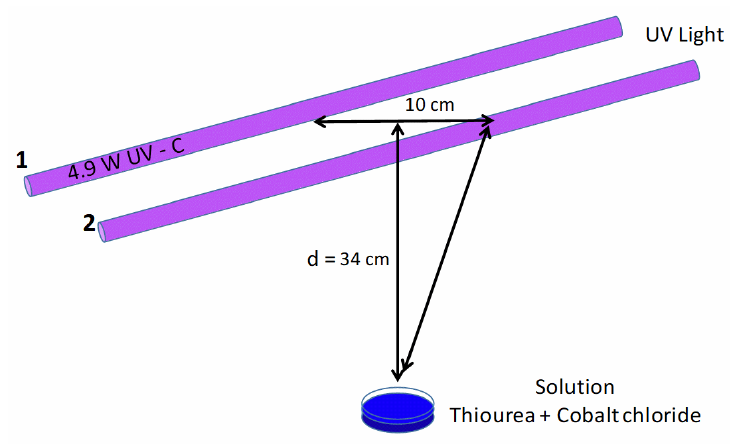
Figure 1. Experimental scheme of the distance between the UV source and the solution. In the second experiment, the same amounts as in the first experiment were used: cobalt chloride hexahydrate (2.37 g) and thiourea (1.52 g) in 10 mL of ethanol at pH 2. Again, under constant stirring and at a constant temperature of 60 ◦ C for 10 min, until complete dissolution. In the end, the solution was filtered and poured into a 60 mm glass Petri